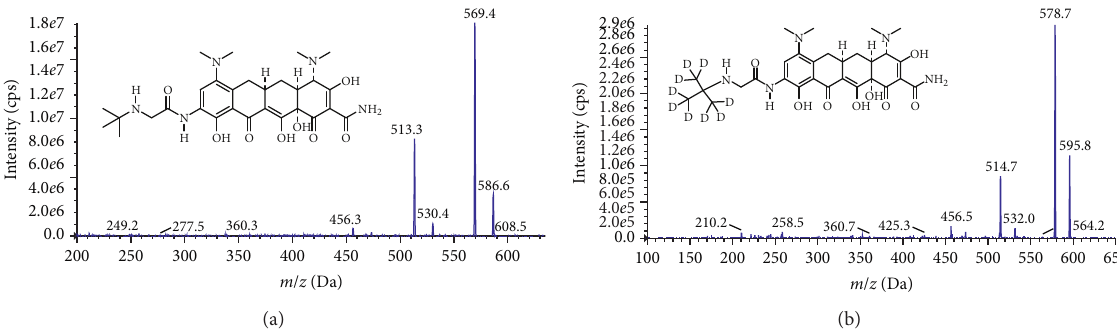
Figure 1: Chemical structures and product ion mass spectra of the [M +H] + ions of (a) tigecycline and (b) [t-butyl-d9]-tigecycline